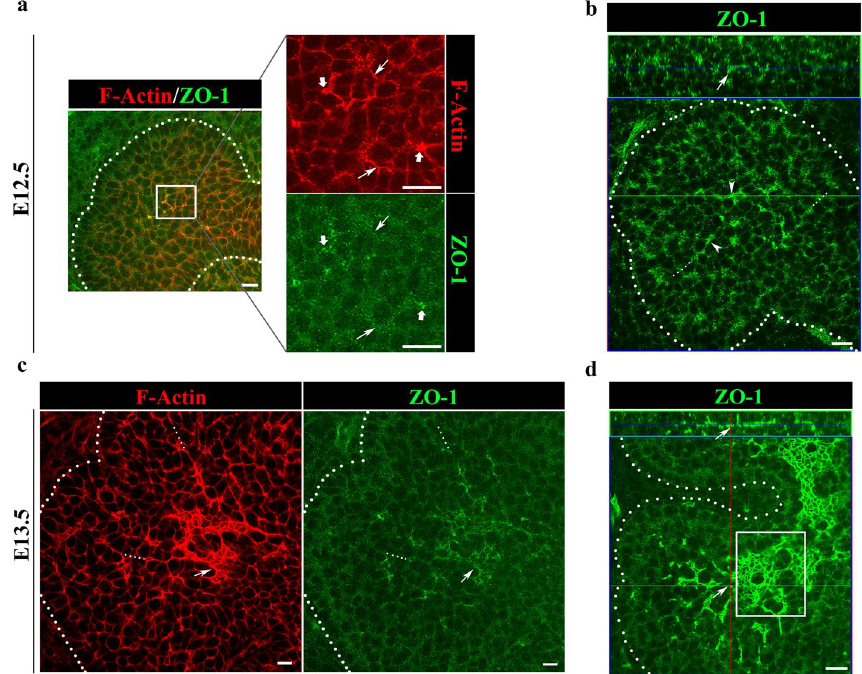
Figure 1. F-actin and ZO-1 set up a roadmap for prospective apical domains in cells destined for ductal lineage. ( a ) Immunofluorescence of paraformaldehyde-fixed SMG explants shows preferential co-localization of F-actin and ZO-1 to one membrane domain in the ductal progenitor cells at the single bud stage, with F-actin delineating converging SCAs (boxed area, → and ➔ ). Merged image size bar represents 10 µm, while split images scale bars are 20 µm. ( b ) Acetone/methanol-fixed tissues prior to immunofluorescence staining revealed that a single bud with three clefts displayed asymmetric distribution of ZO-1 which marked future paths for duct extension. ( c ) Immunofluorescence of paraformaldehyde-fixed E13.5 SMG explants showed that distal regions of buds, defined by the newly formed clefts, displayed ductal paths enriched for F-actin and ZO-1 ( … ). Arrows ( → ) indicate F-actin-enhanced cellular domains with paucity of ZO-1, suggesting that F-actin precedes ZO-1. ( d ) Acetone/methanol-fixed E13.5 SMG buds display proximal regions (boxed area, → ) with strong ZO-1 staining across the expanding field of asymmetry-enriched cells. Size bars, 20 µm. Results are representative of 6 independent experiments (n =